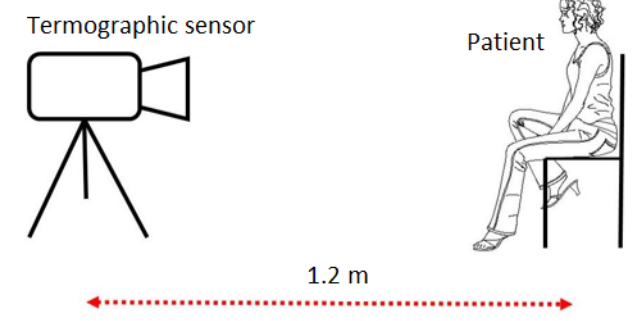
Figure 6. Proposed setup for the thermograms